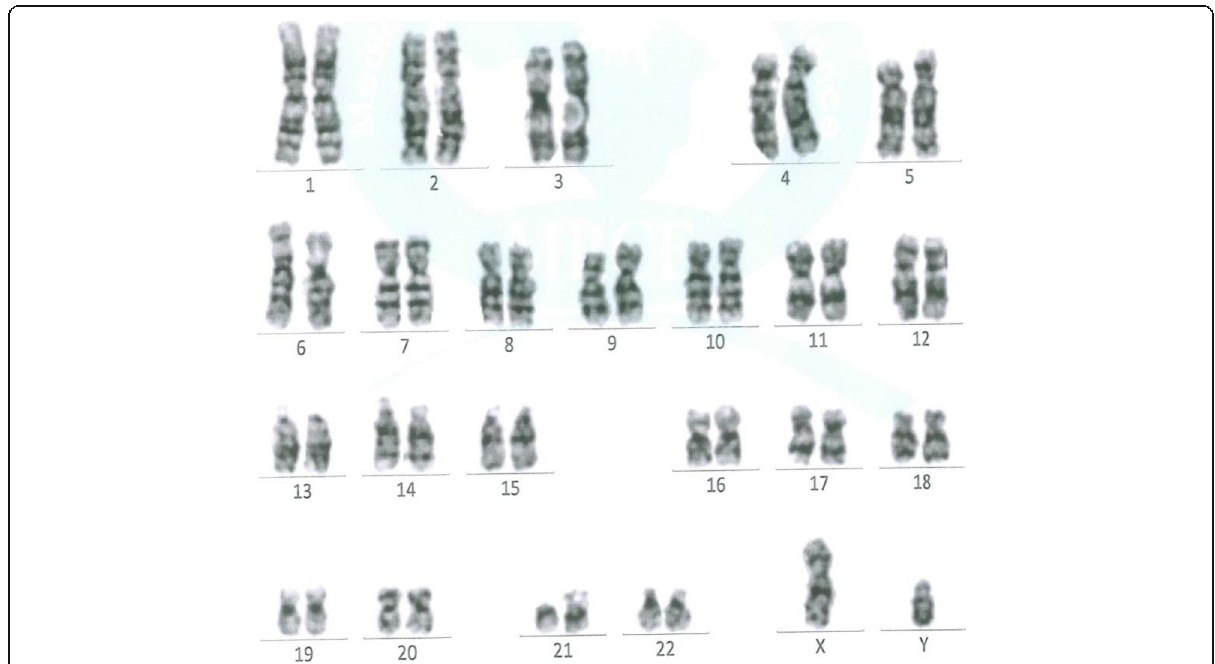
Fig. 3 Karyotyping for male OP-intoxicated patient showing normal male karyotyping 46, XY: by G-banding